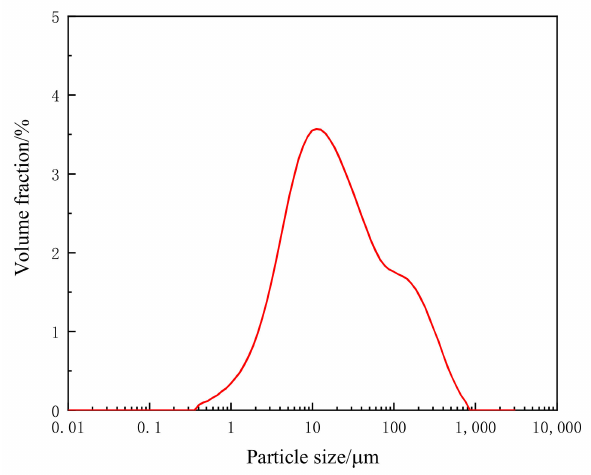
Figure 2. Aluminum dross particle size